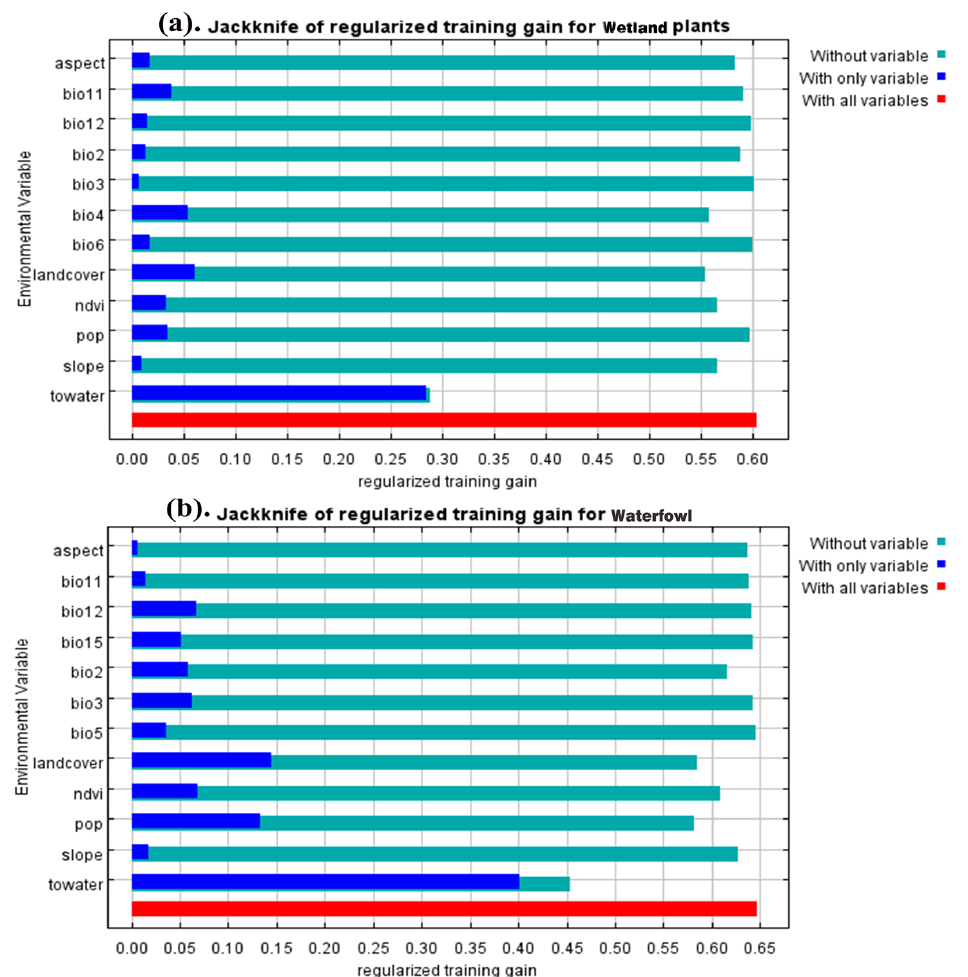
Figure 4. The jackknife test result of environment factor for ( a ) wetland plants and ( b ) waterfowl.